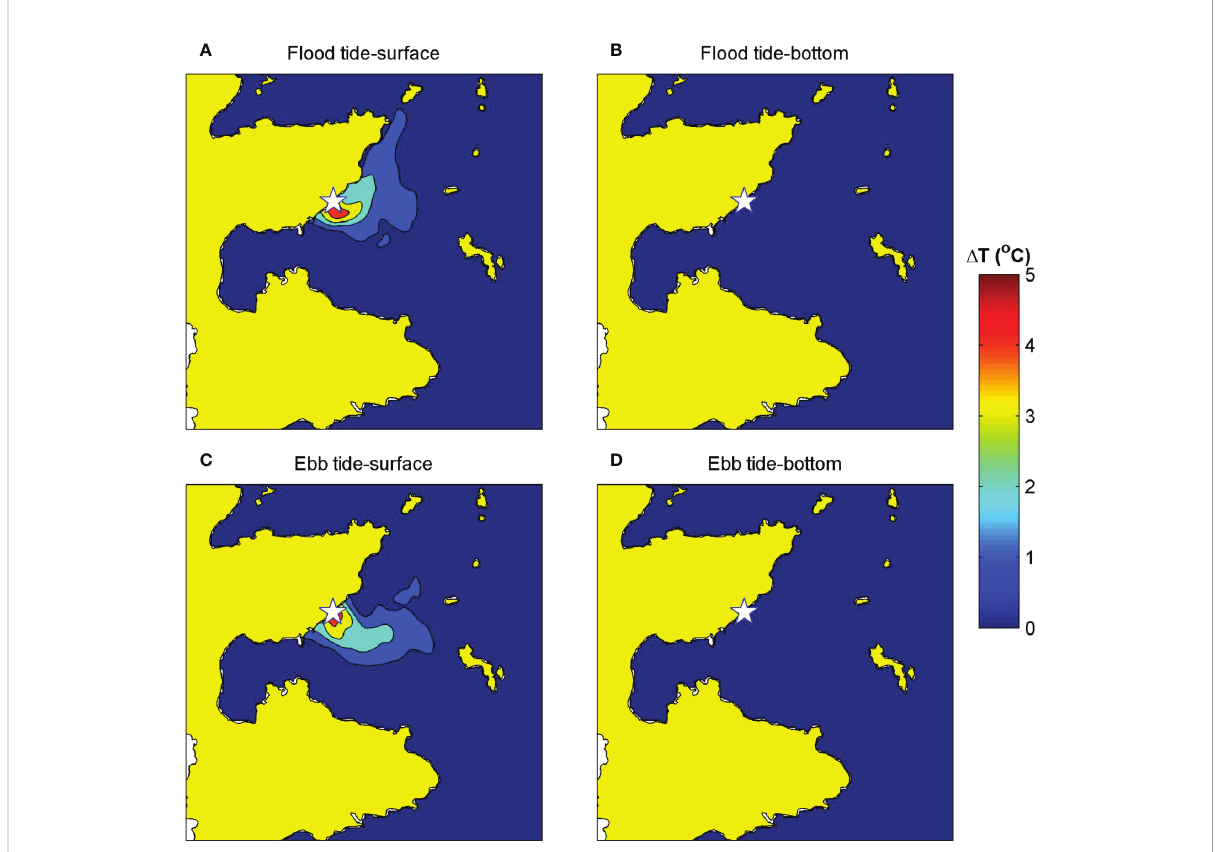
FIGURE 10 Model simulated temperature rise: (A) surface and fl ood tide period; (B) bottom and fl ood tide period; (C) surface and ebb tide period; and (D) bottom and ebb tide period, near the Daya Bay Nuclear Power Plant (DBNPP) during spring tide in